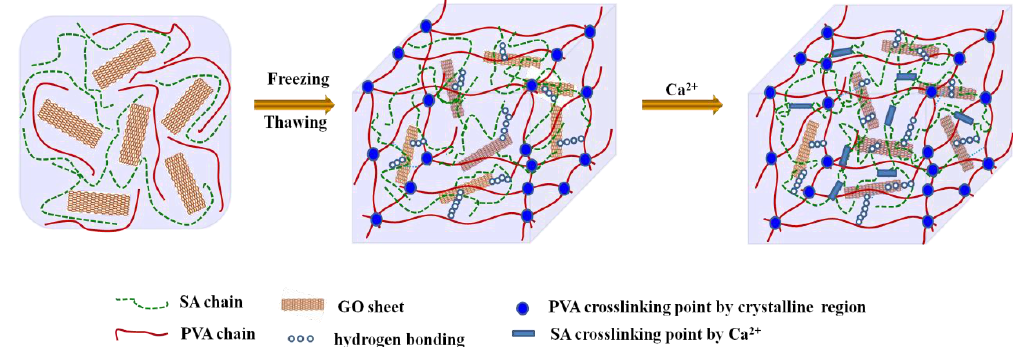
Figure 1. Schematic of crosslinking mechanism of graphene oxide (GO) reinforced double network (DN) hydrogel.